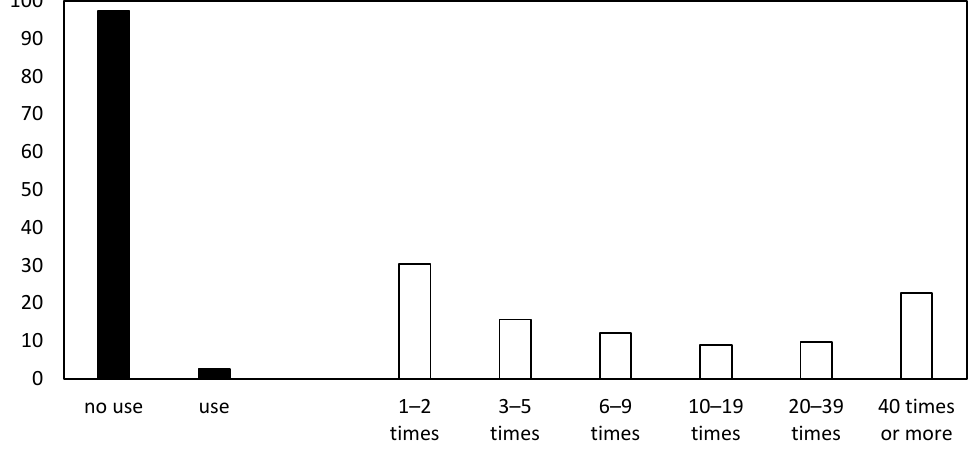
Figure 1. Prevalence in percent of CE-drug misuse during the past 12 months ( ■ , at t 2 , N = 11,197) and respective misuse frequencies from those reporting such drug misuse ( □ , at t 2 , N = 291).